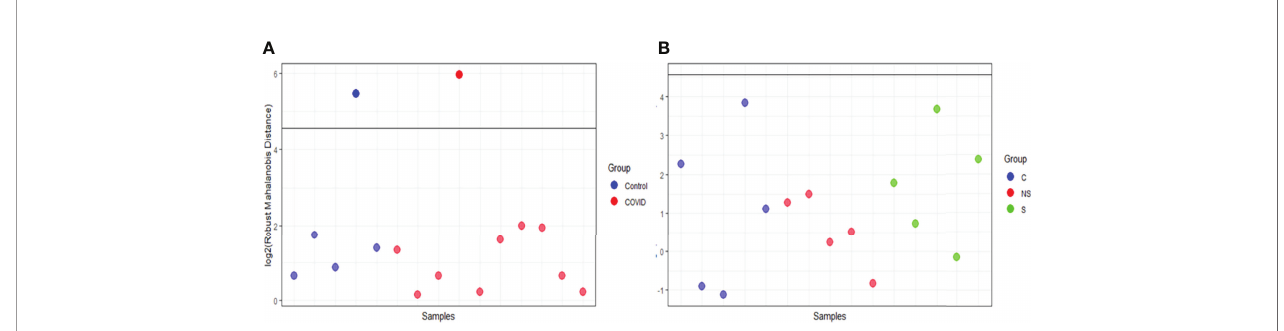
FIGURE 4 | Robust Mahalanobis distance analysis. The threshold of 1e − 04, represented by the line in the graph, corresponds to outliers. (A) RMD of Control vs COVID. (B) RMD of C vs S vs NS. Images analysis and creation performed in pmartR. The Control group (C) is represented by blue dots, COVID-19 survivors (S) by green dots, and COVID-19 non-survivors (NS) by red dots.